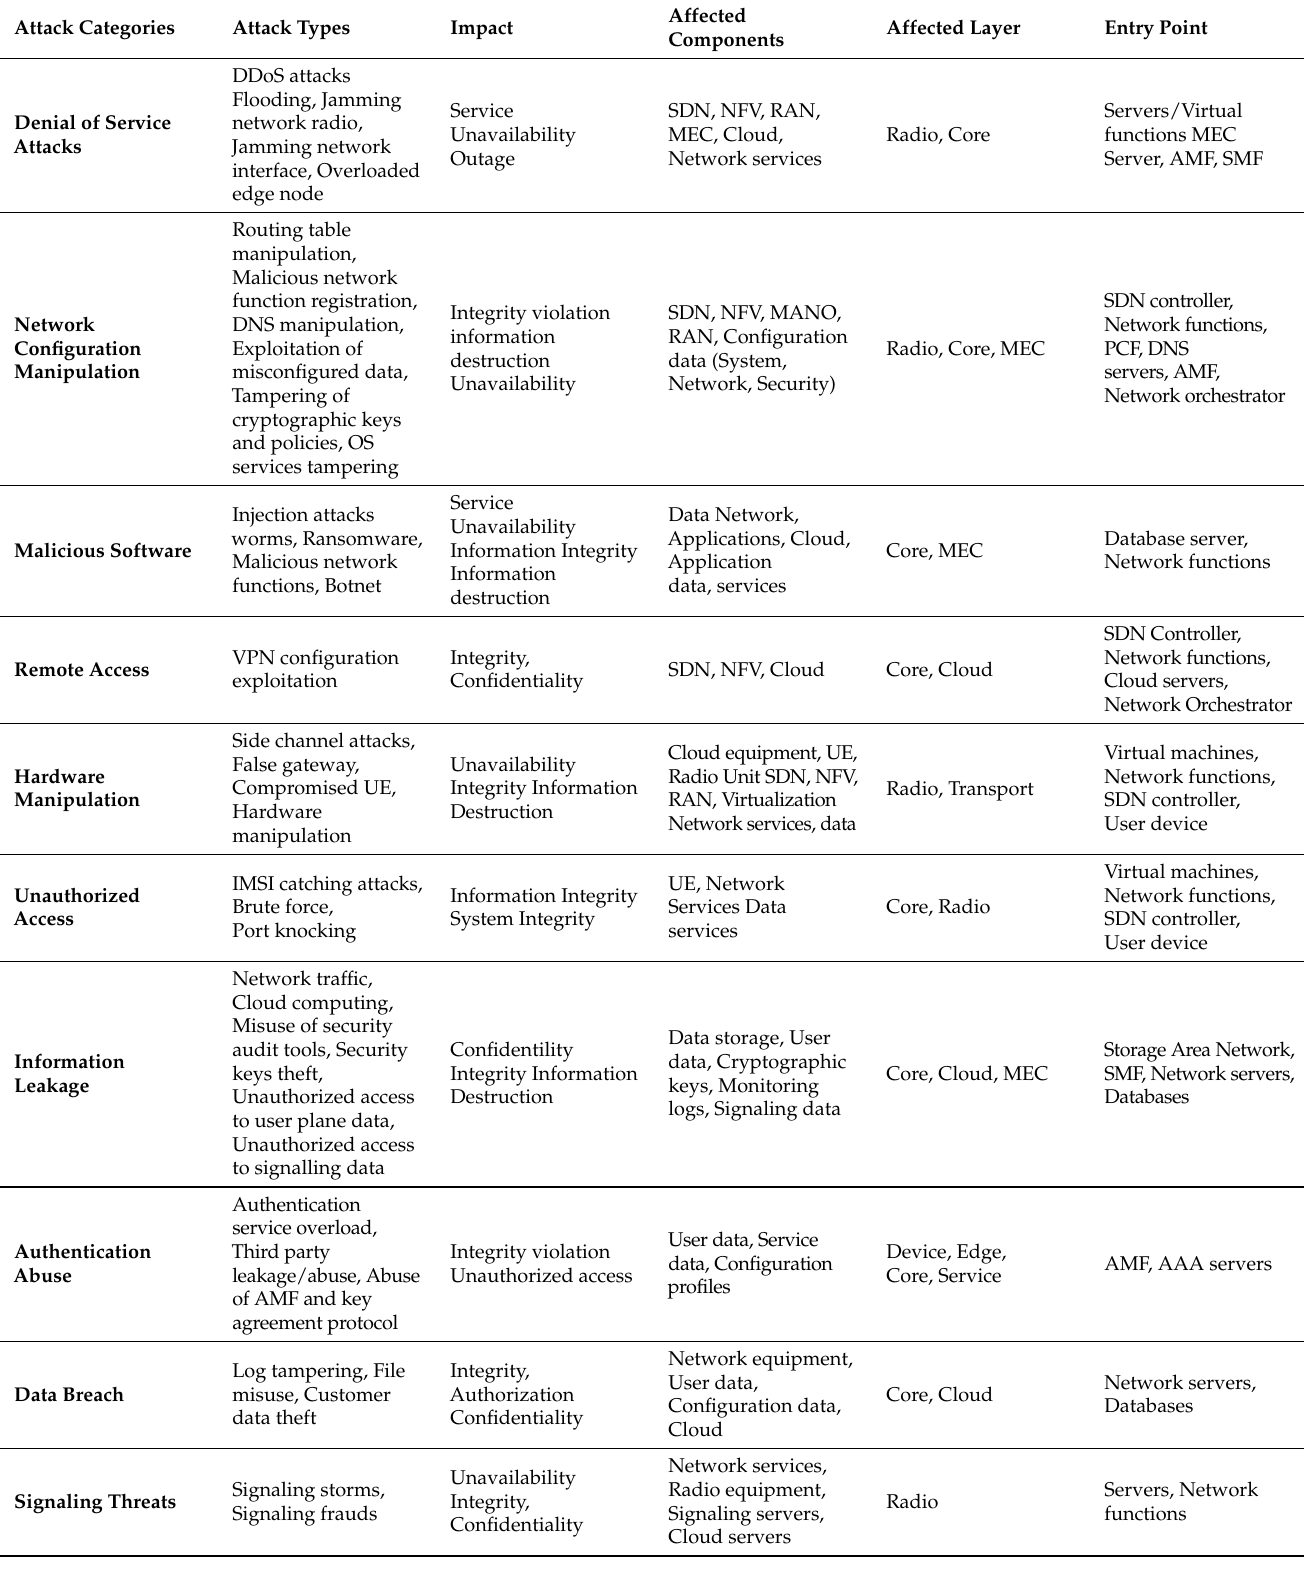
Table 4. Attack categories for 5G-based system mapped with